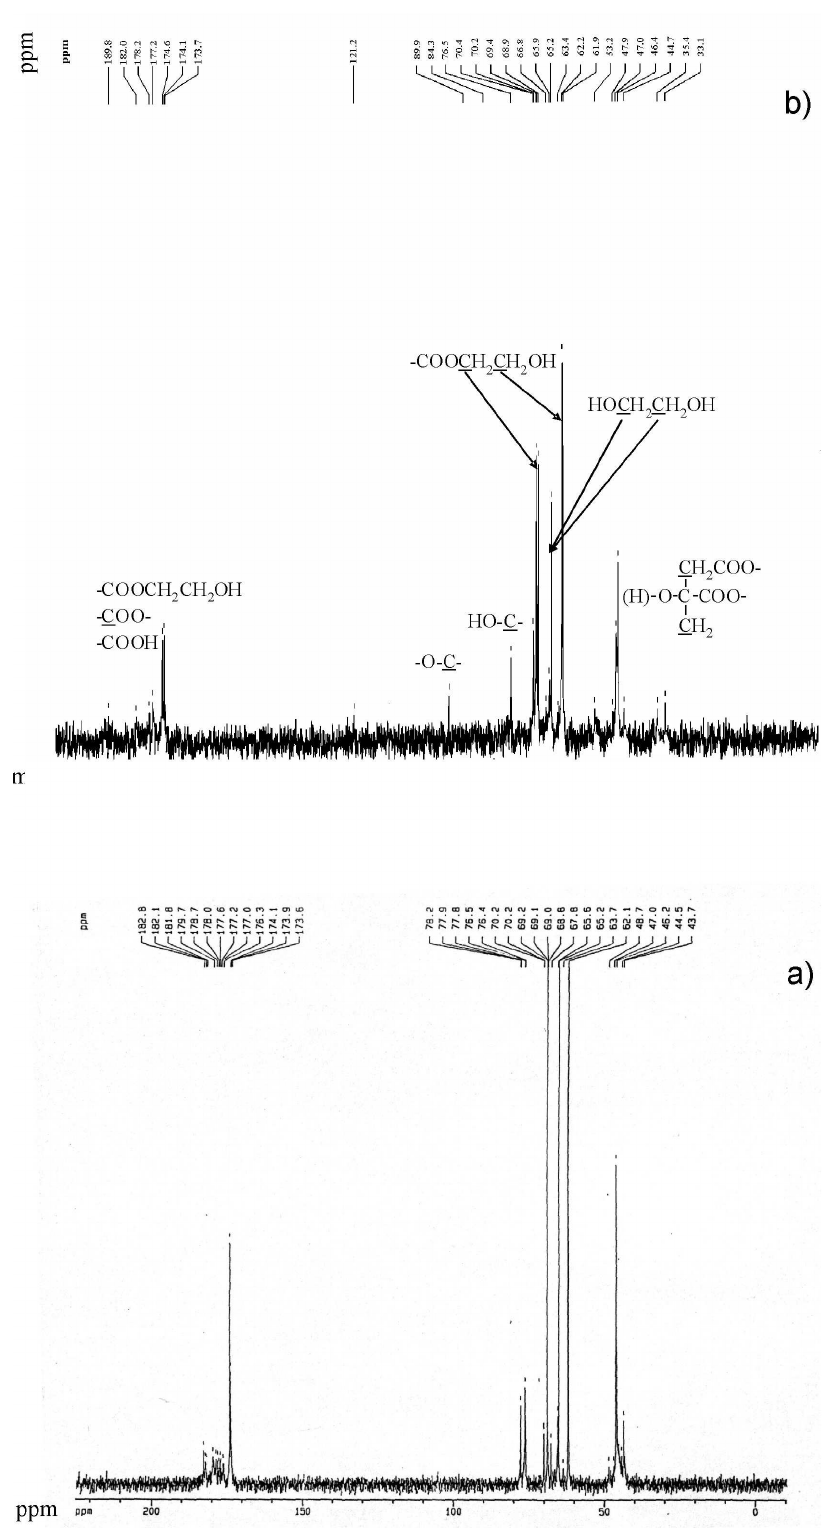
Fig. 2 13 C - NMR spectra of Al- (a) and Y-Al- (b) citric